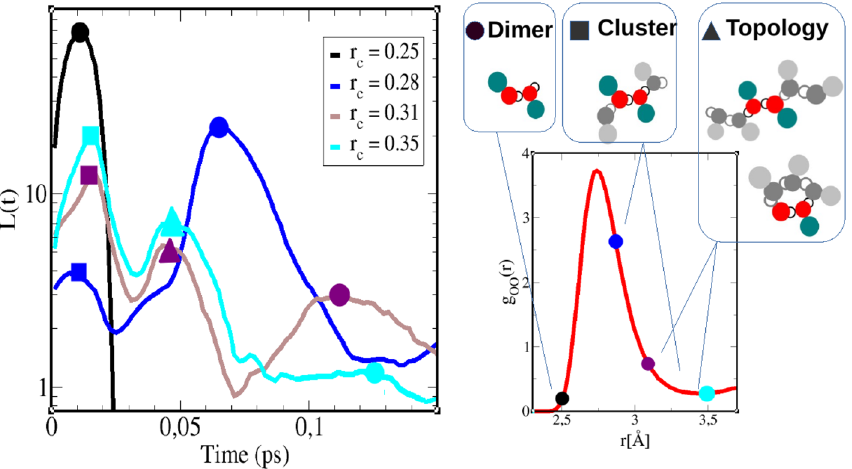
Figure 1. Illustration, for the case of pure methanol, of the correspondance between H-bond life time curves (left panel) for each bonding distances r c and their various peak/maxima (marked with symbols), with the dimer based clusters in relation with the oxygen–oxygen pair correlation function g OO ( r ) (right). The selected r c positions are marked on g OO ( r ) by the same color convention as in the left plot. Methanol molecule is modeled with red site for oxygen, open circle for hydrogen, and larger dark green site for the methyl groups. Only dimers are colored, while methanol molecules part of larger clusters are shown in grey shades. Refer to the text for additional